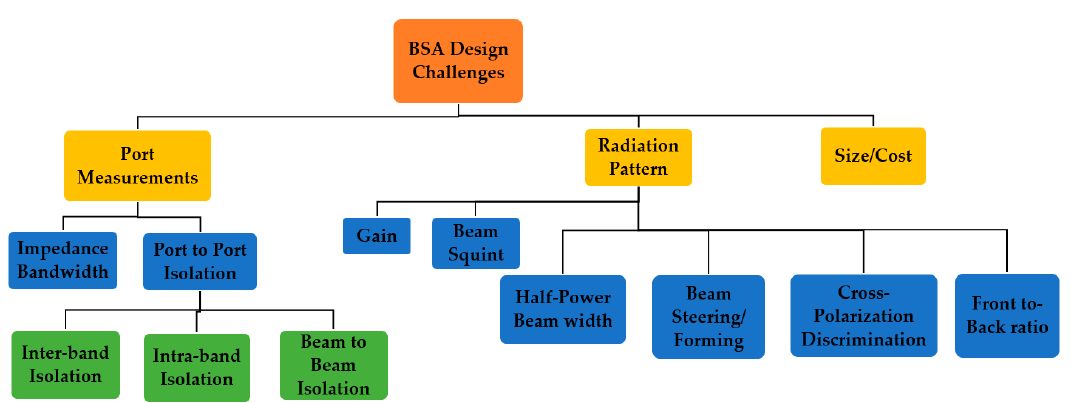
Figure 6. Classification of base station antenna challenges based on design.